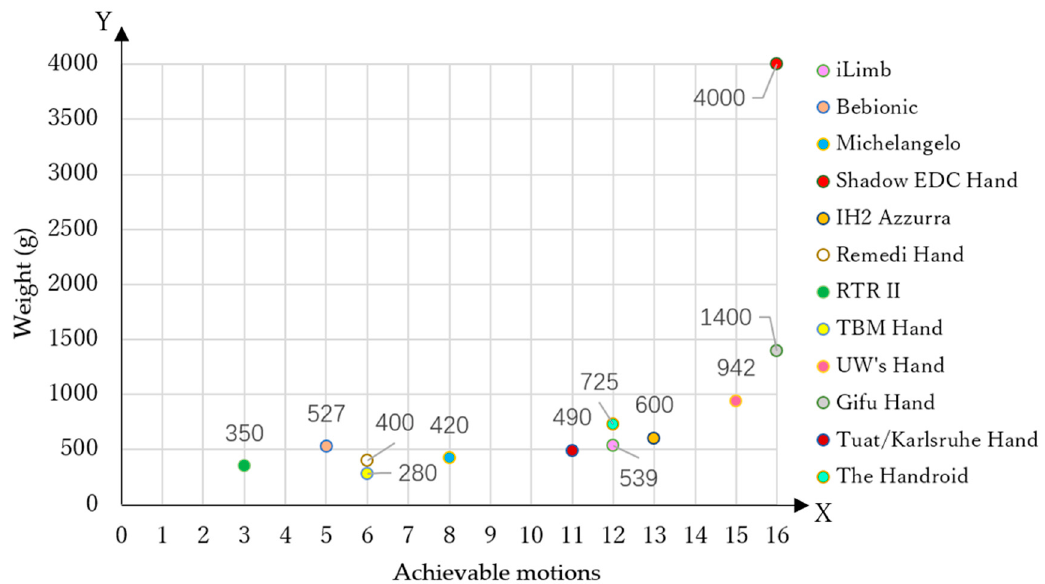
Figure 1. Comparison between achievable types of motion and the entire weight (from i-Limb to the Handroid [10,12–18]): x-coordinates express the number of achievable types of motion based on the Cutkosky taxonomy, not corresponding to each labeled number in Figure 2; y-coordinates express the entire weight of prosthetic hand.